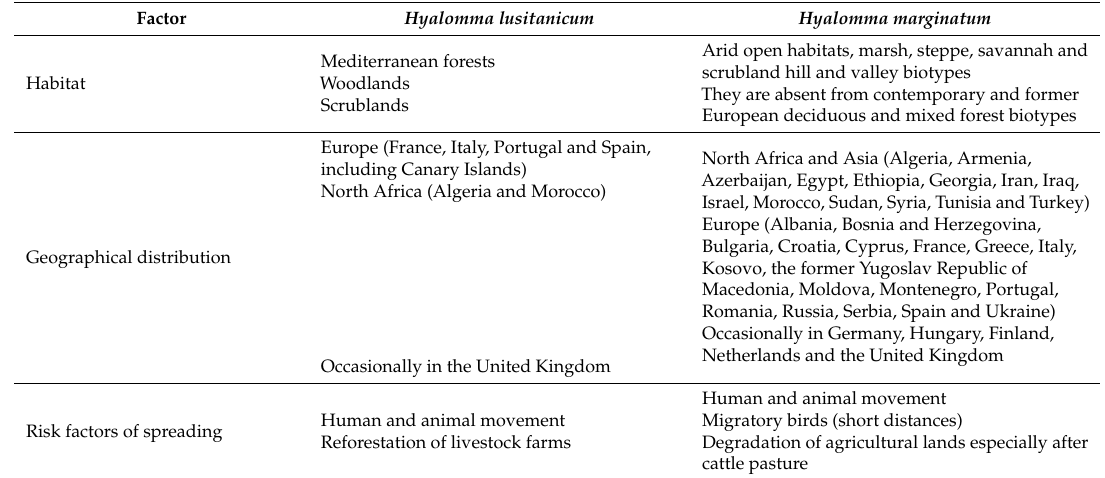
Table 6. Habitats and distribution of Hyalomma lusitanicum and Hyalomma marginatum. Factor Habitat